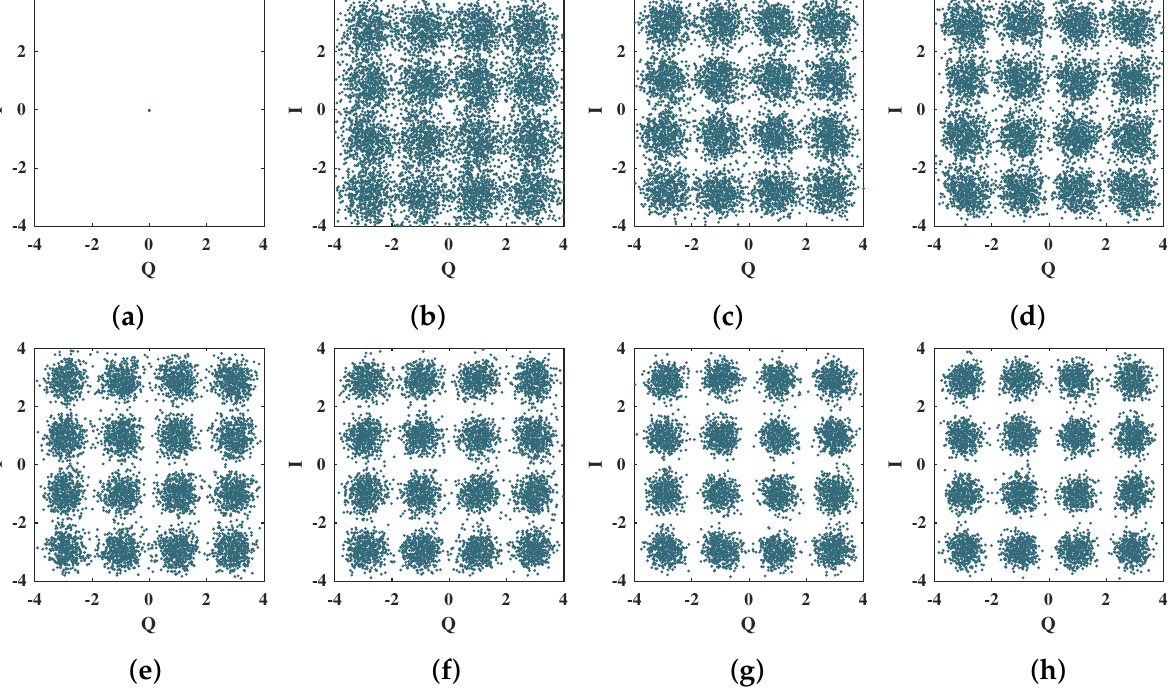
Figure 13. Scatter plots for the 16-QAM symbols at the output of the MMPTRBF during the training period, for